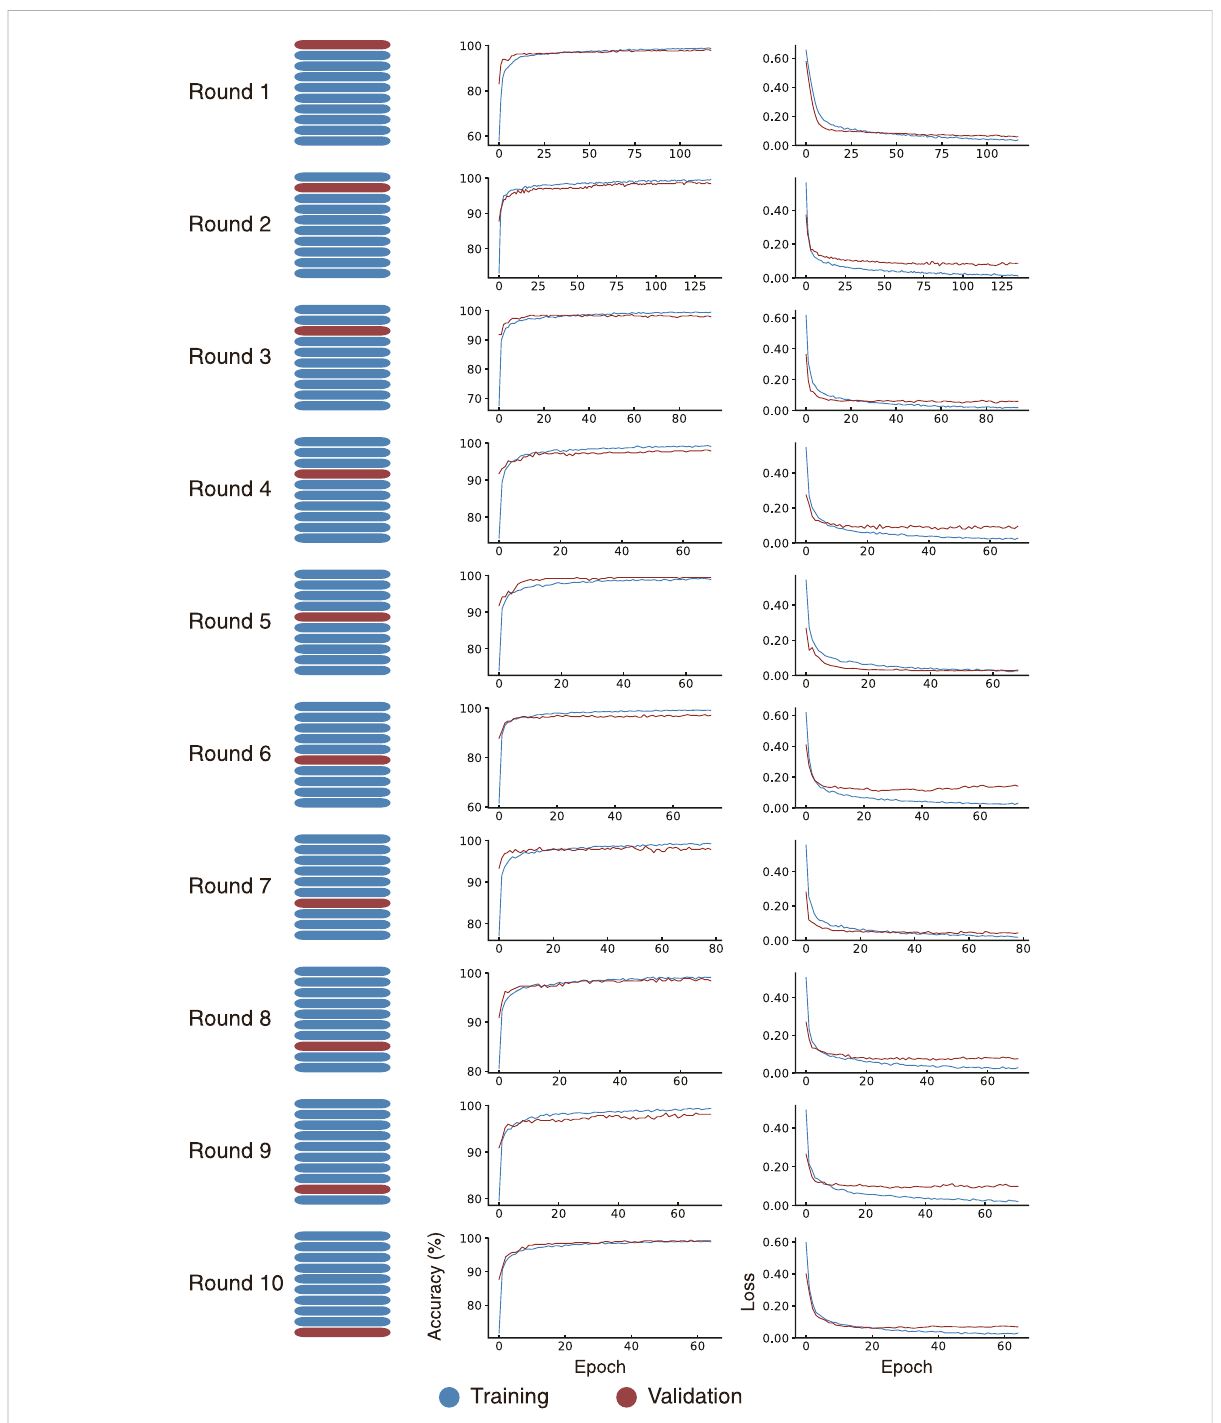
FIGURE 6 The DNN model accuracies and losses on training and testing sets for each epoch in the 10-fold cross-validation procedure. The accuracy and loss reach an approximate constant for both the training and testing